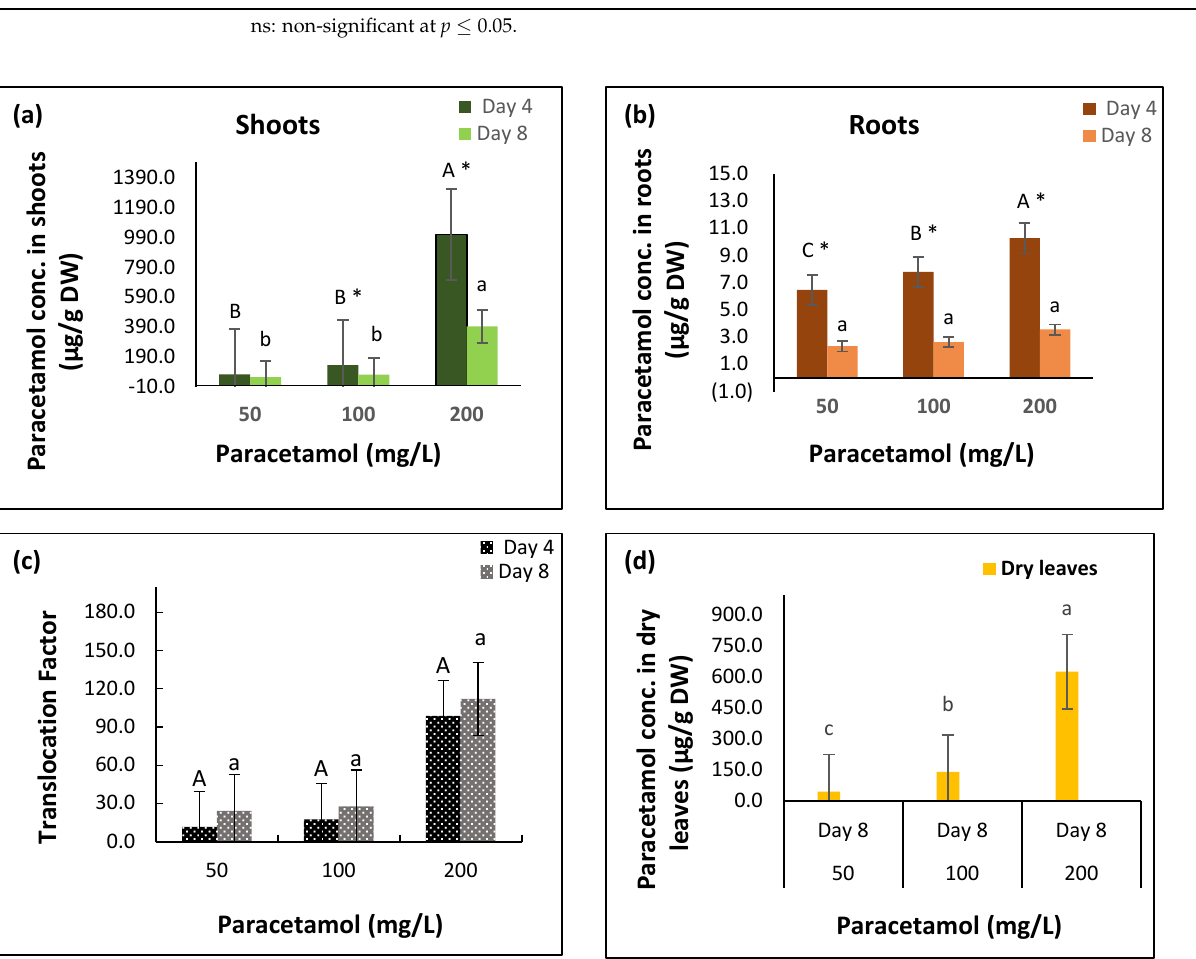
Figure 1. Effect of different paracetamol treatments at different time points on the concentration of paracetamol (µg/g DW) in spinach ( a ) shoots, ( b ) roots, ( c ) translocation factor, and ( d ) dry leaves. Error bars represent means ± S.E. of three biological replicates. Means with different upper-case and lower-case letters indicate significant differences ( p ≤ 0.05) between the different paracetamol treatments at four and eight days, respectively. Asterisks (*) indicates significant differences between four and eight days at a certain concentration. Table 1. Results of two-way ANOVAs showing the effects of different paracetamol treatments, ex- posure periods, and their interactions on the concentration of paracetamol (µg/g DW) in spinach shoots, roots, and translocation factor.